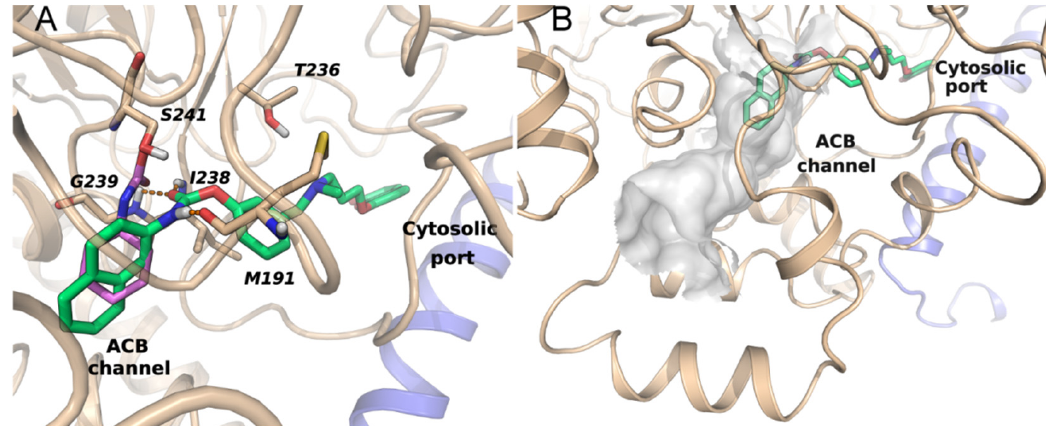
Figure 4. ( A ) Binding mode of 4 (green carbons) within the active site of rFAAH. The coumarin ring occupies the cytosolic port at the interface between the two subunits of the FAAH homodimer (chain A, light blue ribbons; chain B, beige ribbons). The N -naphthyl substituent fits the ACB channel and overlaps the cyclohexyl fragment of URB597 (purple carbons) covalently bound to the catalytic serine in the X-ray structure 3LJ7, superposed to the docking complex. Polar interactions are marked with orange dotted lines. ( B ) Surface of the ACB channel of FAAH with docked 4 .